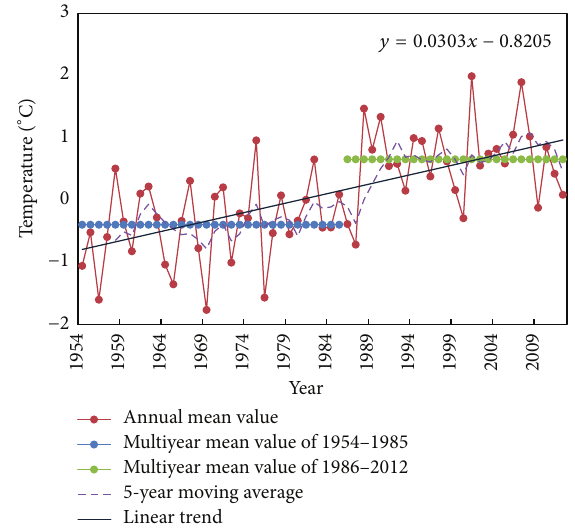
Figure 5: Long-term changes in area-averaged annual mean tem- perature ( ∘ C) in the Amur River